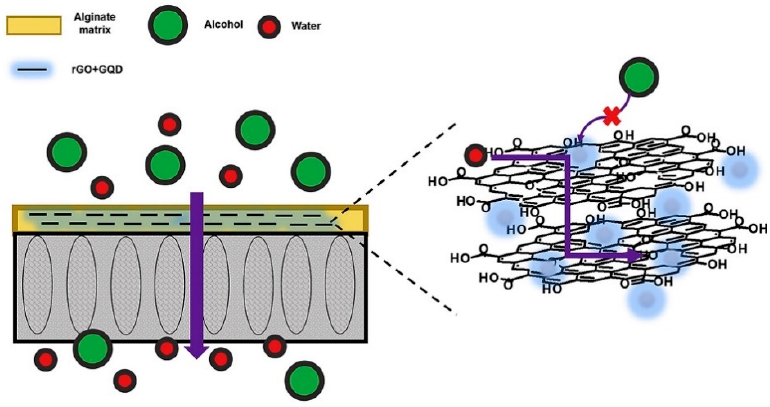
Figure 3. Proposed mechanism of sealing structural defects using Graphene Quantum Dots (GQD).